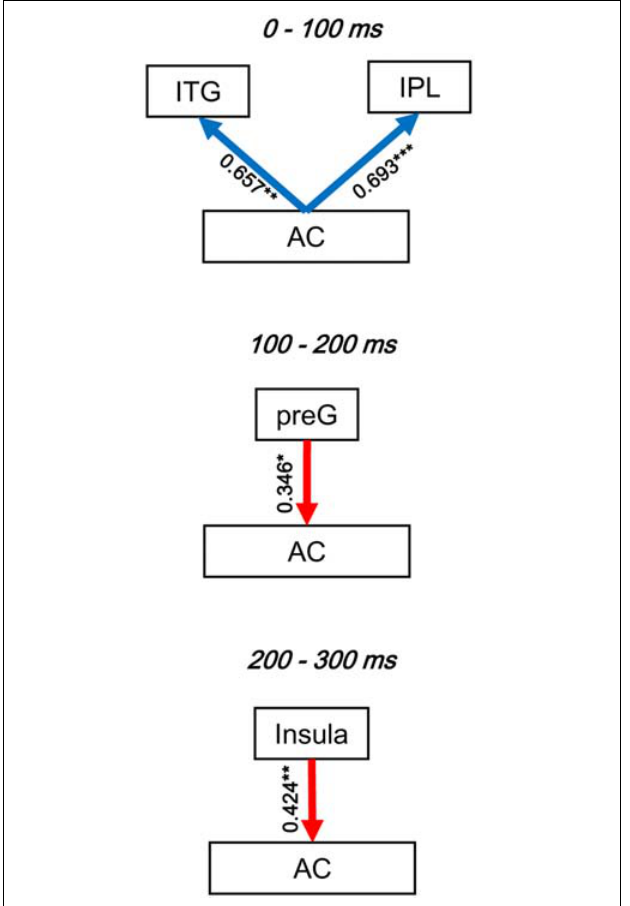
FIGURE 7 | Illustration of the dynamic interactions between the AC local network and functionally connected networks of the AC. The correlation coefficients were obtained by Pearson correlation tests. Blue arrows, bottom-up modulation from the AC to non-auditory areas. Red arrows, top-down modulation from non-auditory areas to the AC. Bold arrows, significant correlation. ∗ p < 0.05; ∗∗ p < 0.01; ∗∗∗ p < 0.001.